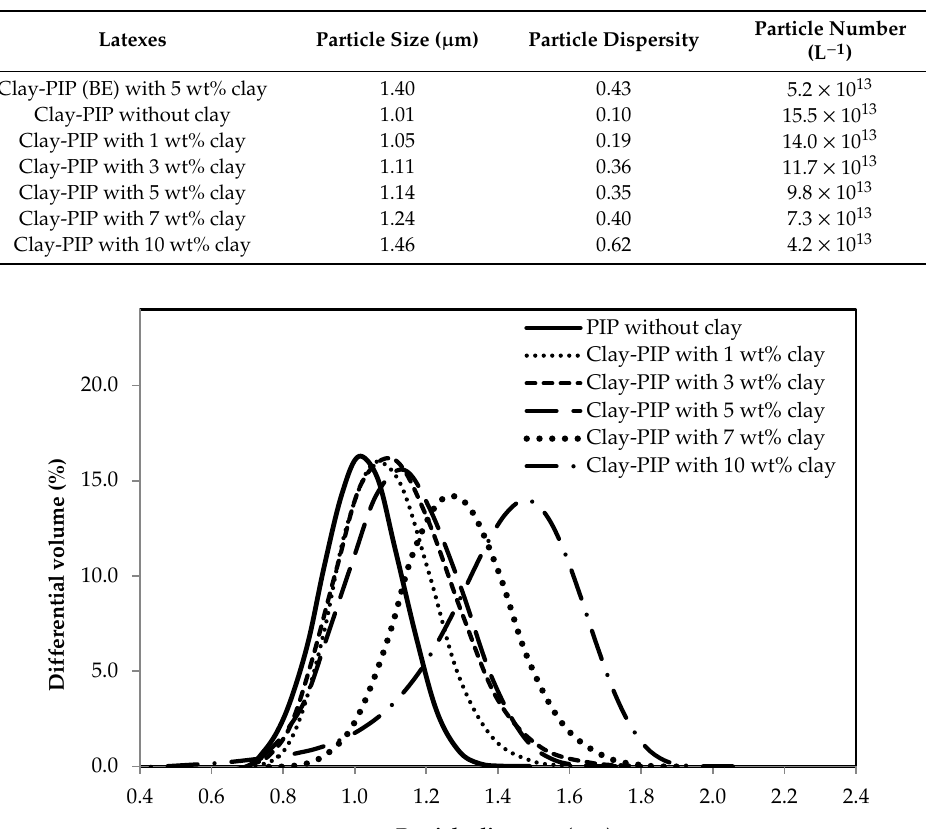
Figure 3. The effect of nanoclay content on the particle size of the nanoclay-modified polyisoprene latexes prepared using SFE polymerization.